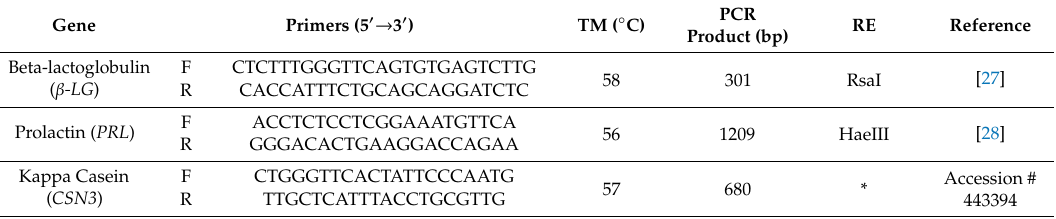
Table 1. Primer information and restriction information for genes of